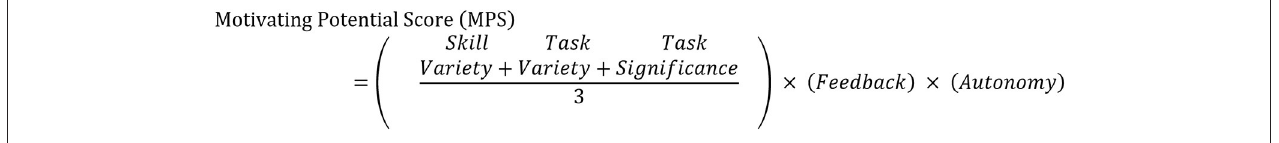
FIGURE 1 | Equation on Job Motivation.